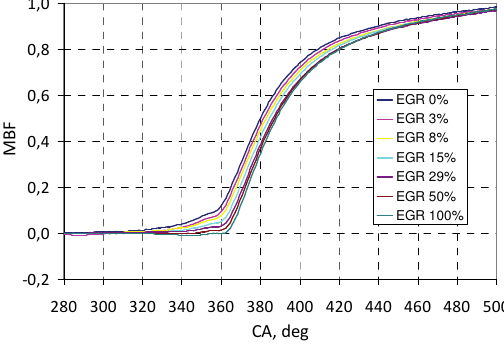
Fig. 9. Mass Fraction Burning course at different EGR valve opening level (1000 rpm, 190 Nm)